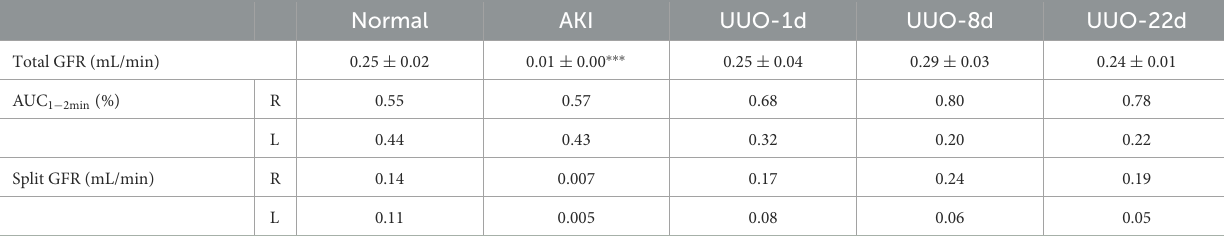
TABLE 2 68 Ga-EDTA dynamic positron emission tonometry- (PET-) derived glomerular filtration rate (GFR).